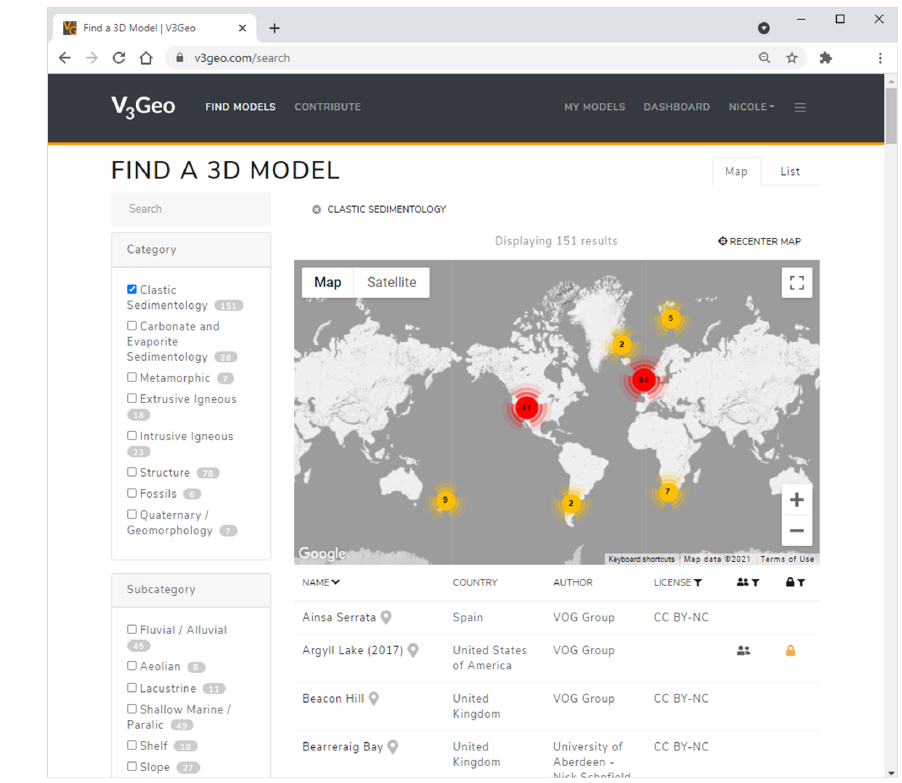
Figure 1. Search interface in the V3Geo web application, showing results when filtering the content by “Clastic Sedimentology”. Map data © Google